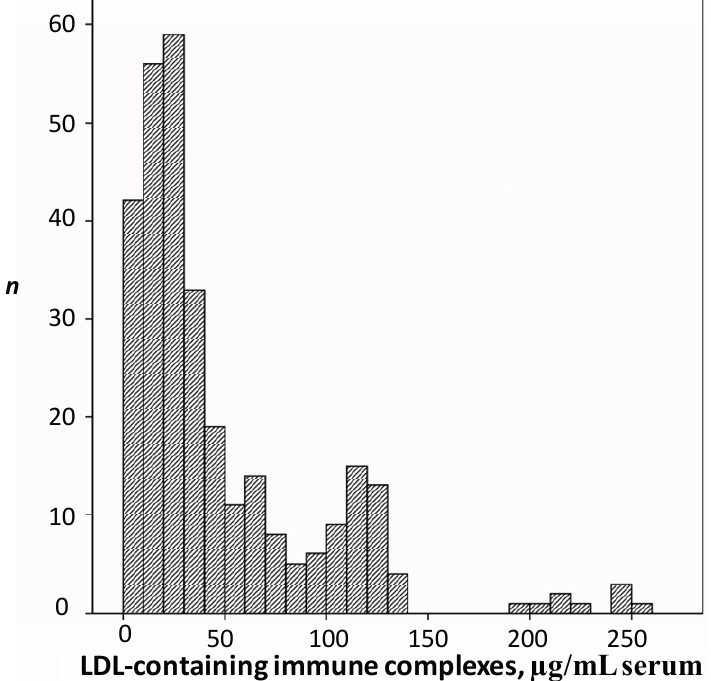
Figure 2. The frequency distribution of LDL-containing circulating immune complexes (CICs) depending on their levels in sera of 318 apparently healthy men (aged 40–78) asymptomatic for ischemic heart disease. The serum content of LDL-containing CICs ( μ g/mL serum) is shown in the horizontal axis. The vertical axis shows the number of observations ( n